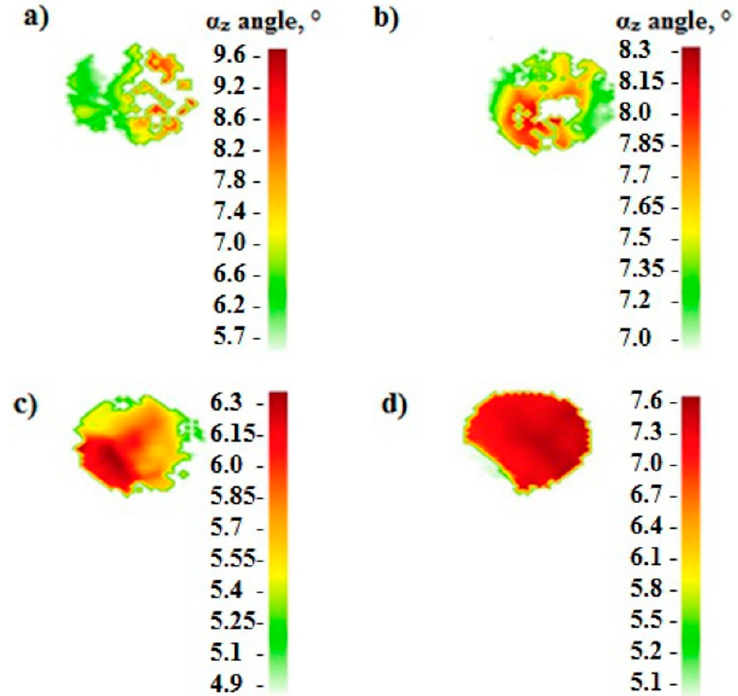
Figure 6. The values of the α z angle on the surface of cross-section of the CMSX-4 superalloy casting withdrawn at the rate of: ( a ) 1, ( b ) 3, ( c ) 5, ( d ) 7 mm/min.